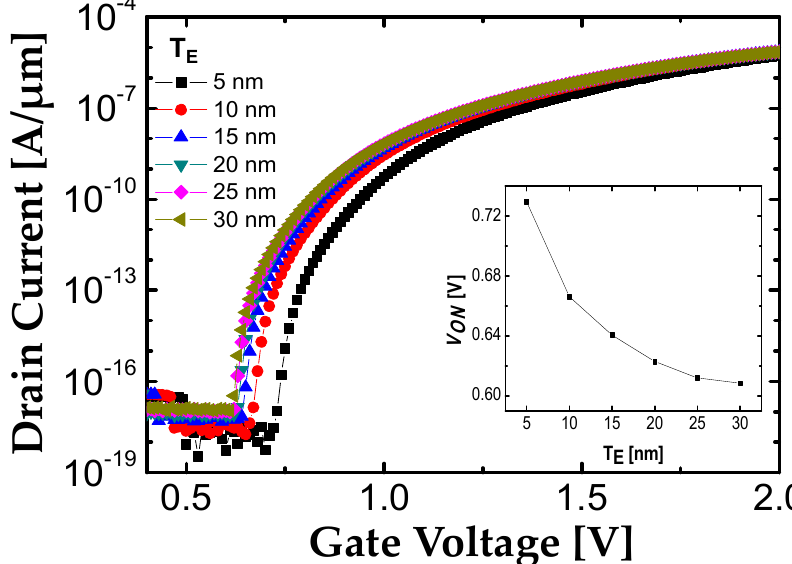
Figure 4. Transfer characteristic with the various T E at V DS = 0.7 V. The inset figure shows extracted V ON with the variation of T E ranging from 5 to 30 nm.